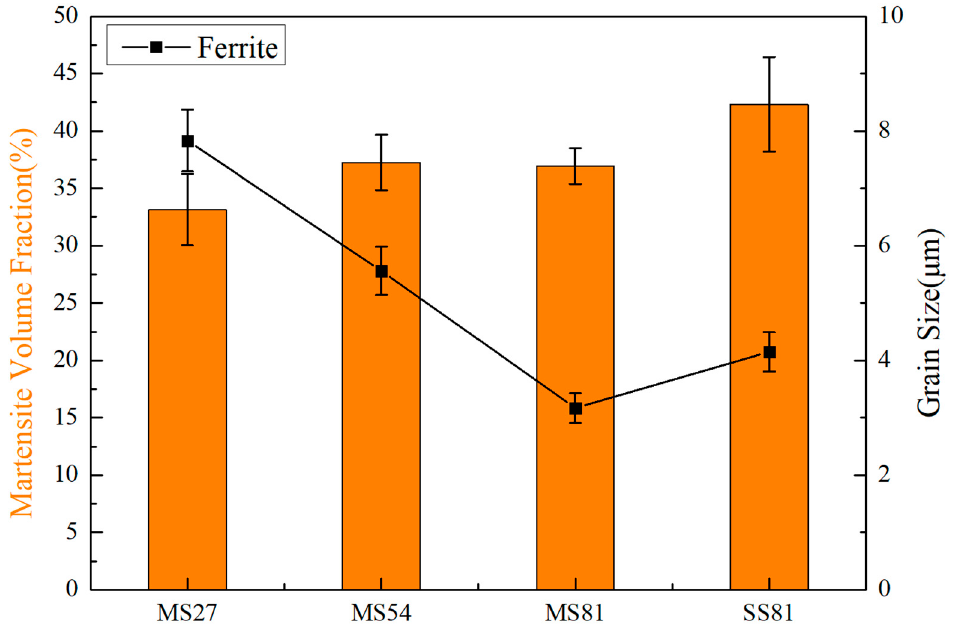
Figure 4. Ferrite grain size and volume fraction of martensite in MS27, MS54, MS81, and SS81. Table 2. The average of the measurements and the qualitative description of the components in the microstructure shown in Figure 3.